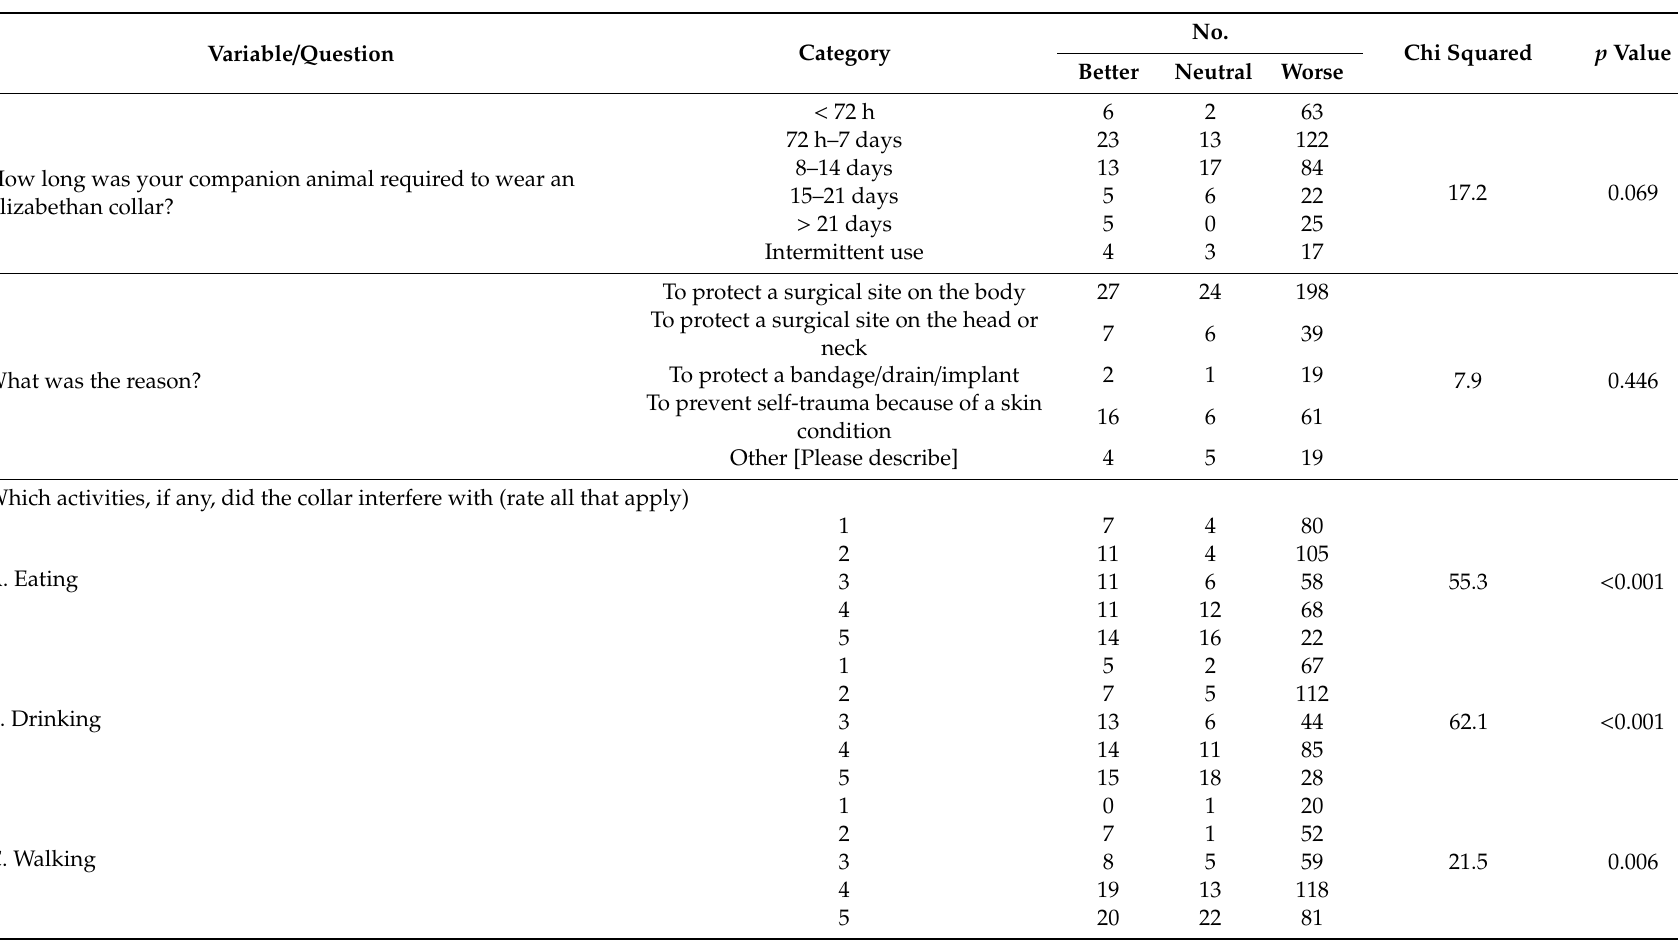
Table A2. Chi-square univariate analysis of responses from participants in an online survey of welfare implications of Elizabethan Collar use on companion dogs and cats, conducted in 2019. Predictor variables were screened for an association with the outcome (better, neutral or worse quality of life score). Significant variables in bold ( p <